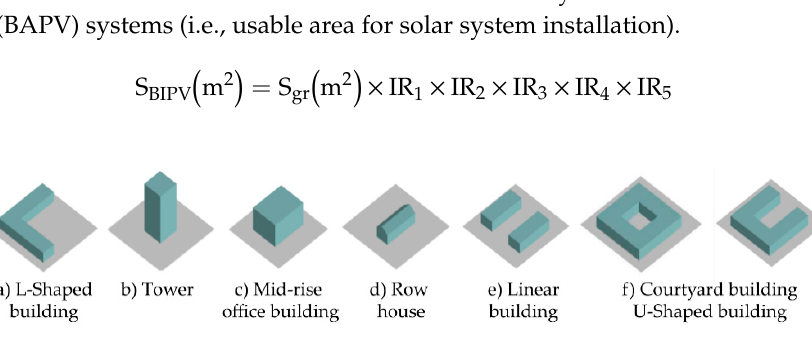
Figure 5. The most common types of building typologies analyzed in Trondheim.